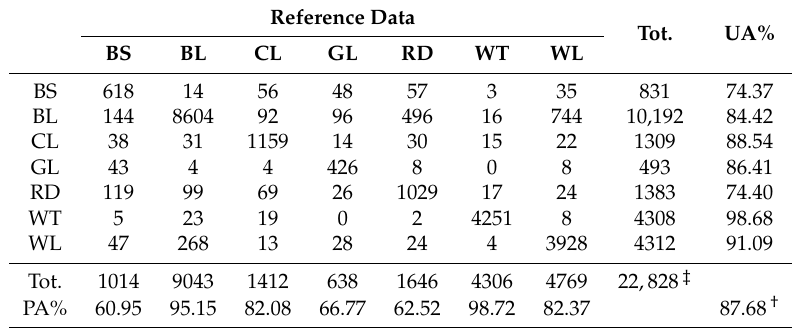
Table 4. Example confusion matrix for 7-class urban land cover classification derived from SPOT-5 image and its spatial information using the Random Forests classifier (Scenario